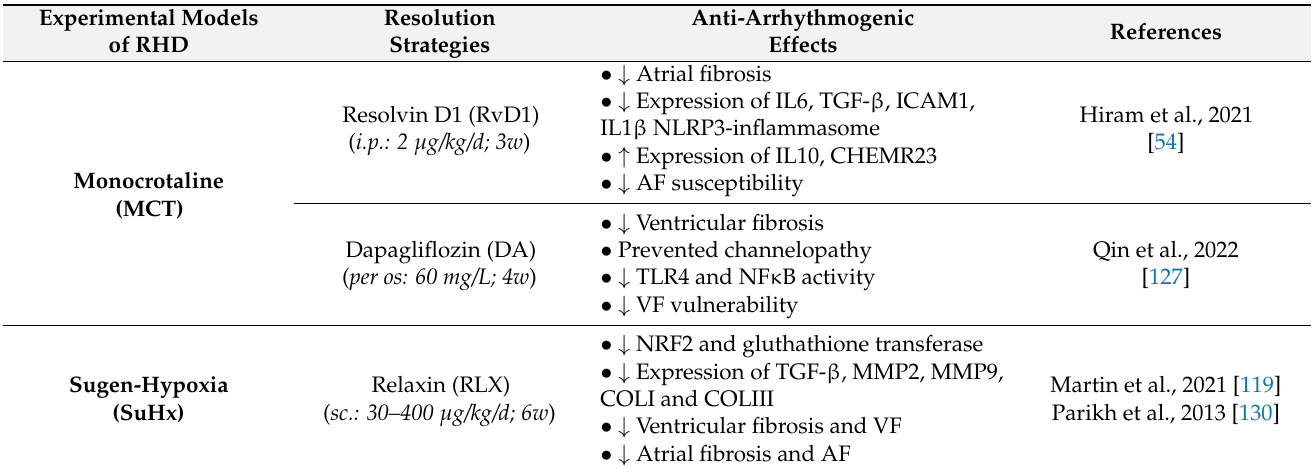
Table 2. Recent resolution strategies in experimental models of RHD. Review of recently tested resolution strategies in the treatment of arrhythmogenic structural and electrical remodeling resulting from severe pulmonary hypertension generated by MCT and SuHx in rats. RvD1 has been shown to significantly reduce atrial fibrous content while decreasing AF vulnerability in MCT rats. DA prevented ventricular arrhythmias via reduction of NF κ B activity in MCT rats. RLX prevented atrial and ventricular fibrosis and fibrillation, while reducing the expression of notorious proinflammatory cytokines and proteins. Abbreviations: AF: Atrial Fibrillation; CHEMR23: chemerin receptor 23; COL: Collagenase; DA: dapaglifozin; ICAM1: intracellular adhesion molecule 1; IL: interleukin; i.p.: intra peritoneal; MMP: Matrix Metalloproteinase; MCT: monocrotaline; NLRP3: NACHT, LRR, and